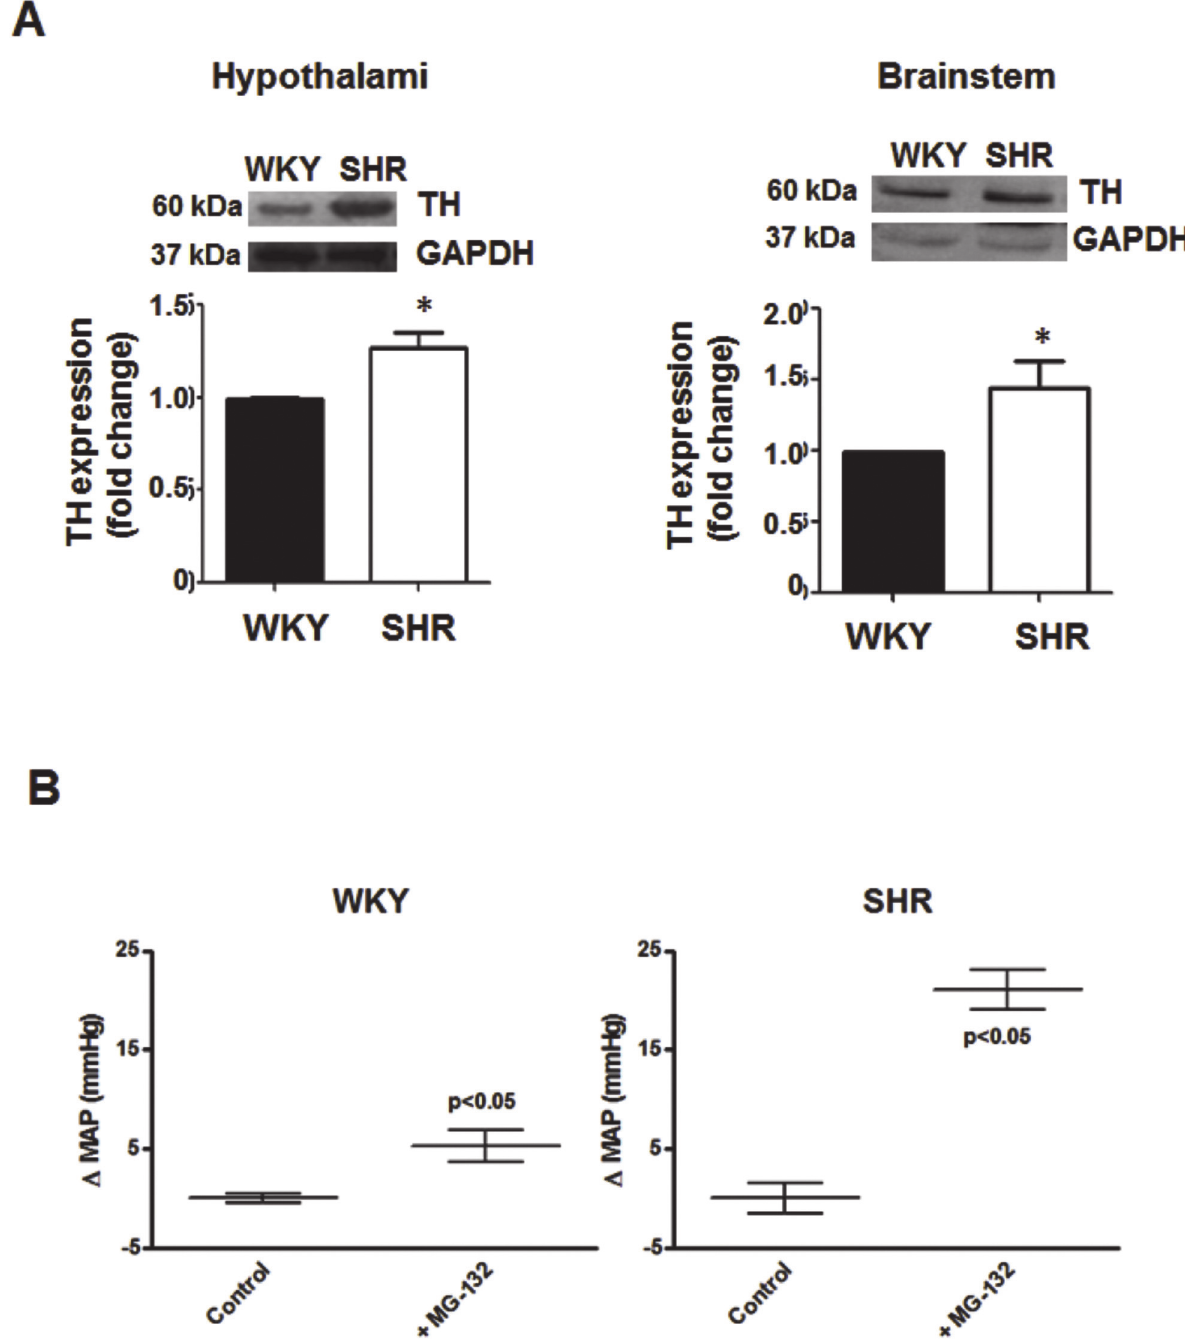
Fig 7. TH protein level in the hypothalamus and brainstem of WKY or SHR rats. A, TH protein level was assessed by Western-blot as described under Methods. Blots were stripped and reprobed for GAPDH to assess protein loading. Signals from TH protein level were normalized to GAPDH levels. Each bar represents the mean ± SEM (n = 7). * P < 0.05 as compared to WKY. B, Change in mean arterial pressure (MAP) in WKY and SHR after intracerebroventricular injection of aCSF (control) or the proteasome inhibitor MG-132. Values are mean ± SEM (n = 7). * P < 0.05 as compared with basal.